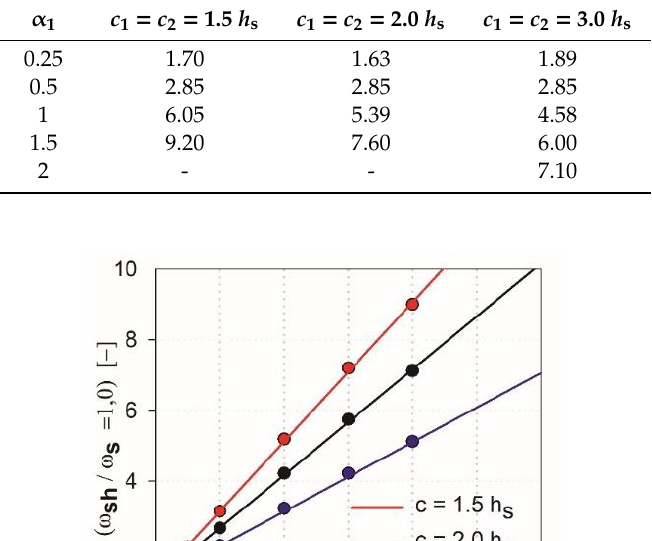
= 2.0: ( a ) for the EC2 standard; ( b ) for the ACI code. 1